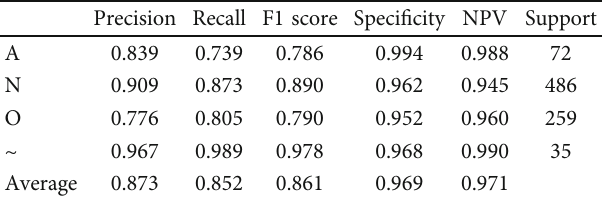
Table 4: Classi fi cation index score